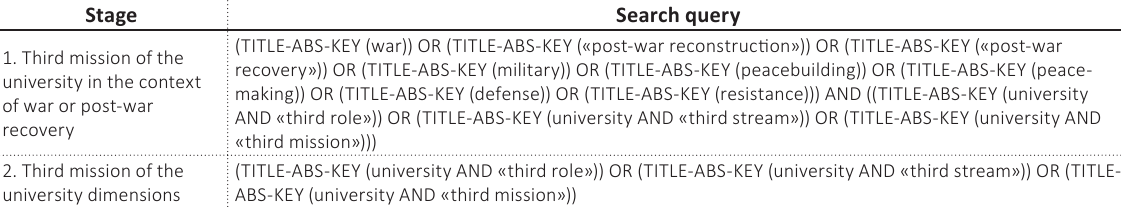
Table 1. Design of the study Stage Search query 1. Third mission of the university in the context of war or post-war